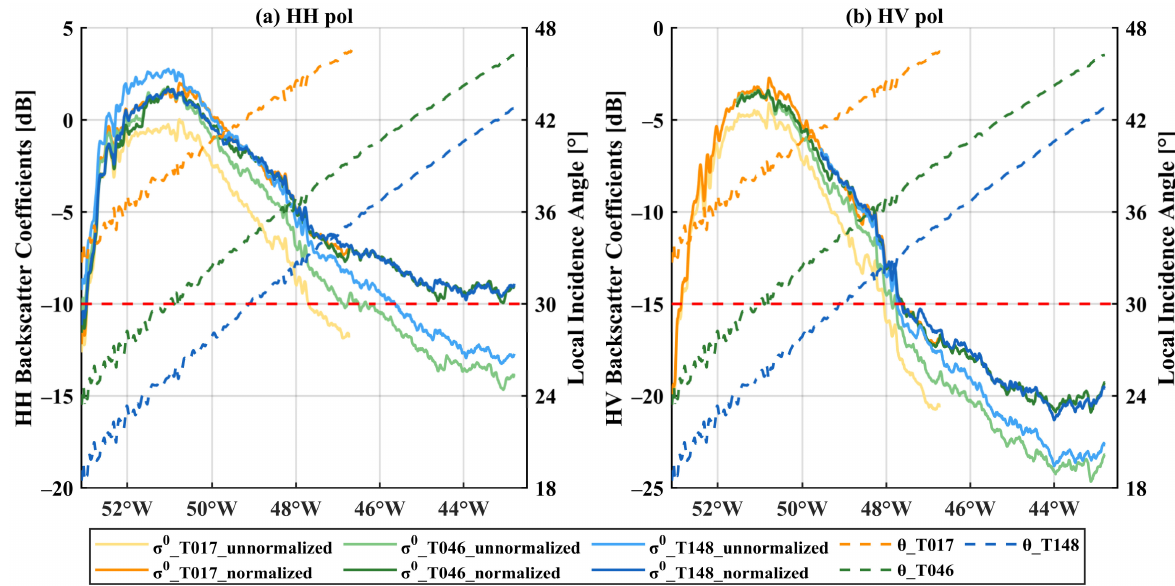
Figure 8. The backscatter coefficients profile along the red line in Figure 7a, covering the tracks 017, 046, and 148. The left vertical axis shows the backscatter coefficients’ variation and the right one shows the corresponding incidence angle change. EW1 of the HV images was removed. The red dashed line indicates the reference incidence angle of 30 ◦ .